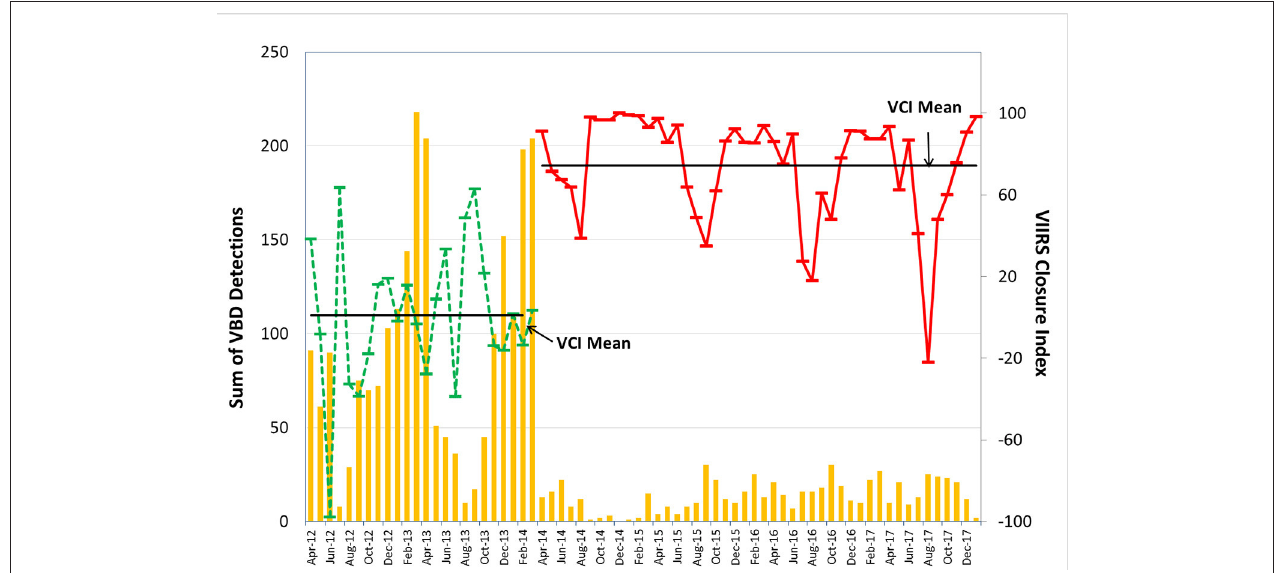
FIGURE 8 | The vertical bars indicate the monthly VIIRS boat detection tallies for the Cauayan closure area from April 2012 through January 2018 The points with connecting lines indicate the VCI values, with the axis labels on the right. The closure VCI are red and pre-closure blue.